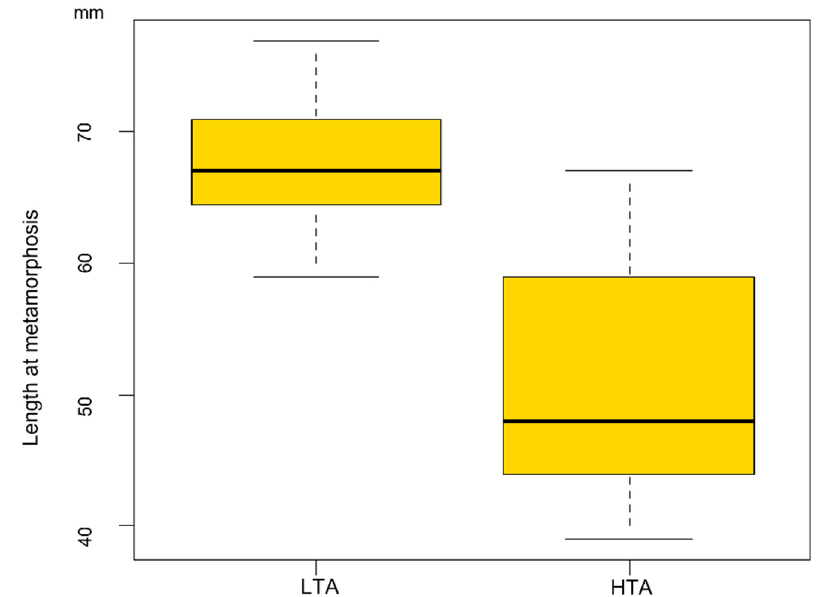
Figure 3. Boxplot showing the relationship between the size at metamorphosis reached by larvae and the food treatment experienced. LTA = low trophic resources availability; HTA = high trophic resources availability.